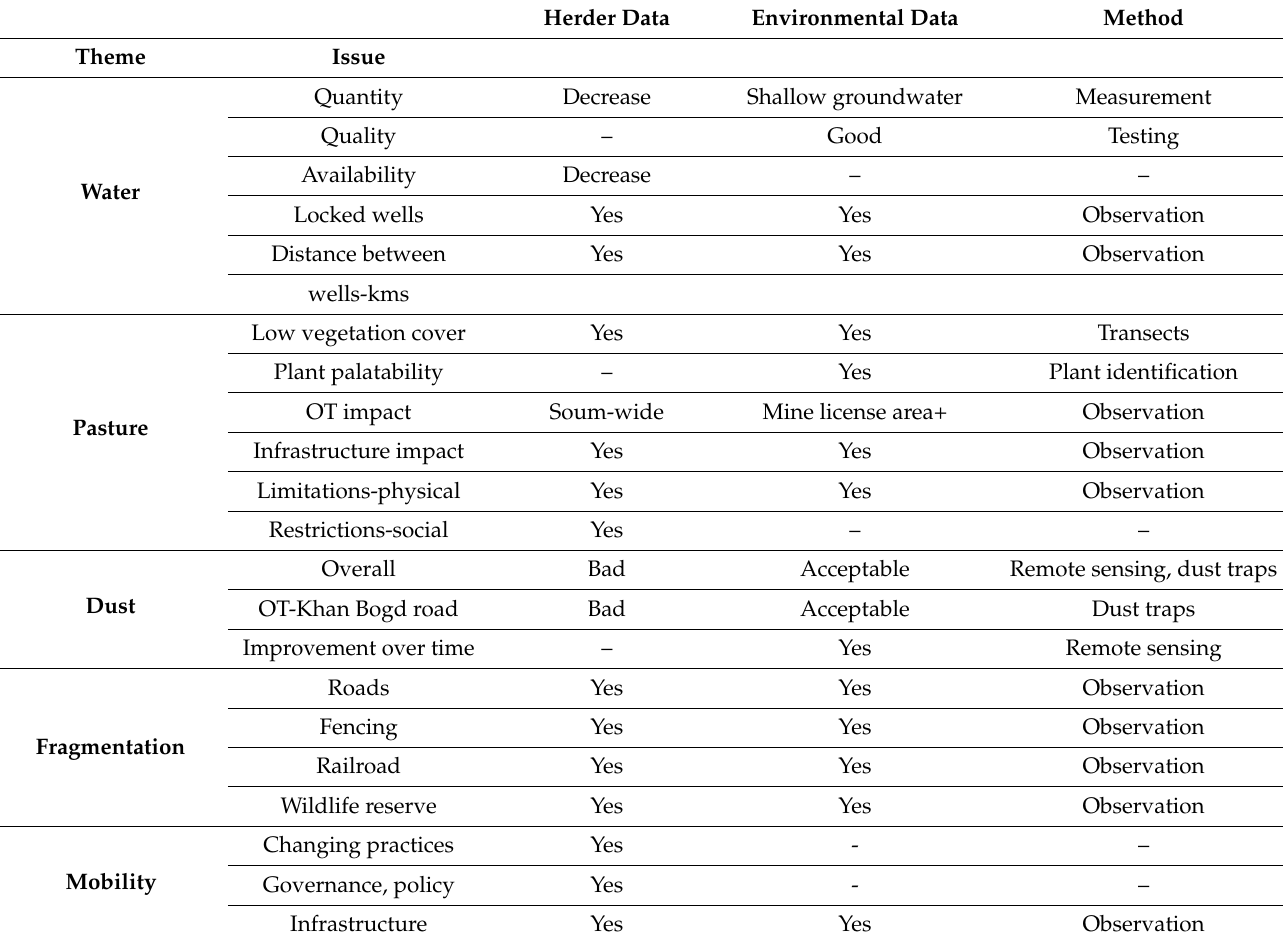
Table 6. Comparative results from herder interviews and environmental investigation on key issues. Herder